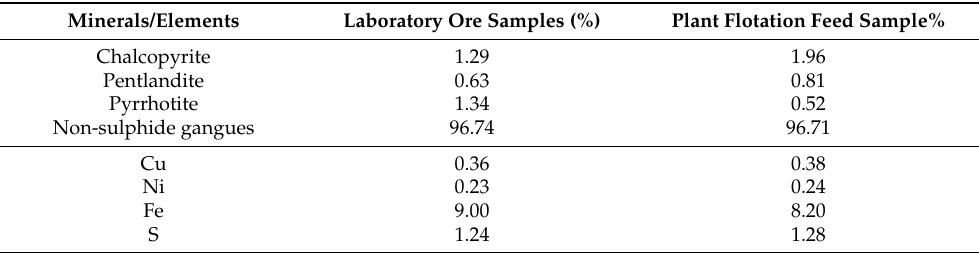
Table 1. Mineral and elemental assays used in the study.